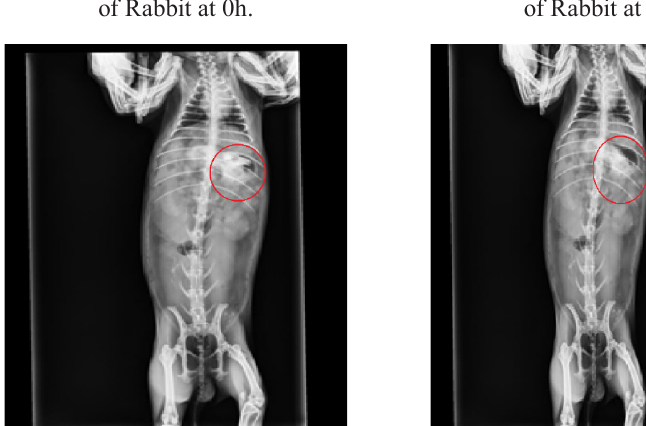
Figure 8(B) - X-ray image of Rabbit at 1h.